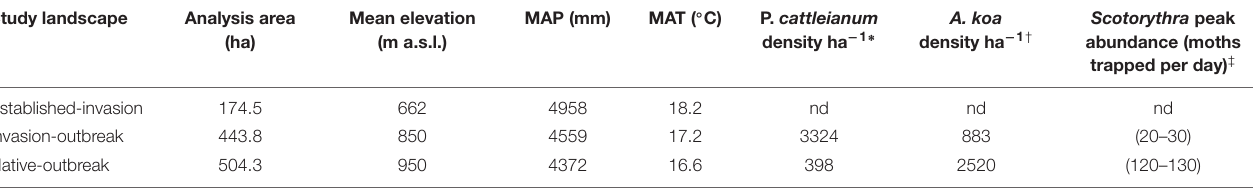
FIGURE 1 | Change in top-of-canopy height (TCH) in forests of the Laup¯ahoehoe study region (600–1100 m a.s.l.), located on the eastern slope of Mauna Kea volcano, Hawai‘i island (155 ◦ 15 (cid:48) 54.63 (cid:48)(cid:48) W, 19 ◦ 56 (cid:48) 11.13 (cid:48)(cid:48) N). The black outline is the extent of the Laup¯ahoehoe forest reserve. Areas in red represent the greatest amount of canopy height loss between 2007 and 2016. The lower forests outlined in white (600–700 m a.s.l.) are dominated by invasive tree species that were established well before 2007(established-invasion). Forests outlined in brown (800–900 m a.s.l.) are in the process of invasion by alien tree species (invasion-outbreak), and the native trees have experienced a defoliation event from a koa moth ( Scotorythra paludicola ) outbreak in 2013. Upper forests in pink (900–1000 m a.s.l.) are native with minimal presence of alien tree species (native-outbreak); however, they were also heavily defoliated by the 2013 koa moth outbreak. TABLE 1 | Study landscapes analyzed within Laup¯ahoehoe sub-montane forests. Study